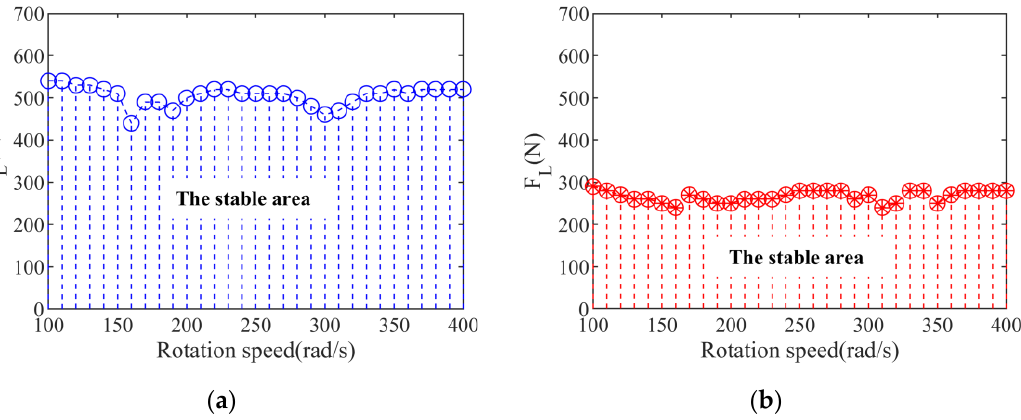
Figure 15. The stable operation area of the two systems under load conditions. ( a ) The conventional MSDS. ( b ) The nonlinear MSDS. MSDS. ( b ) The nonlinear MSDS.